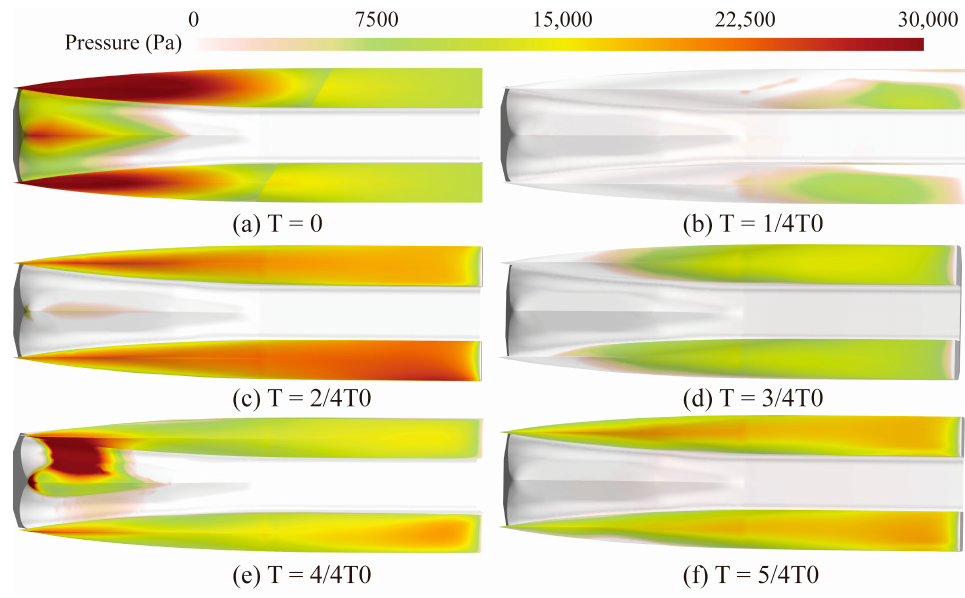
Figure 25. Pressure distribution at the bottom of the USV under 7 level sea state with the 30° wave direction (Positive pressure area).